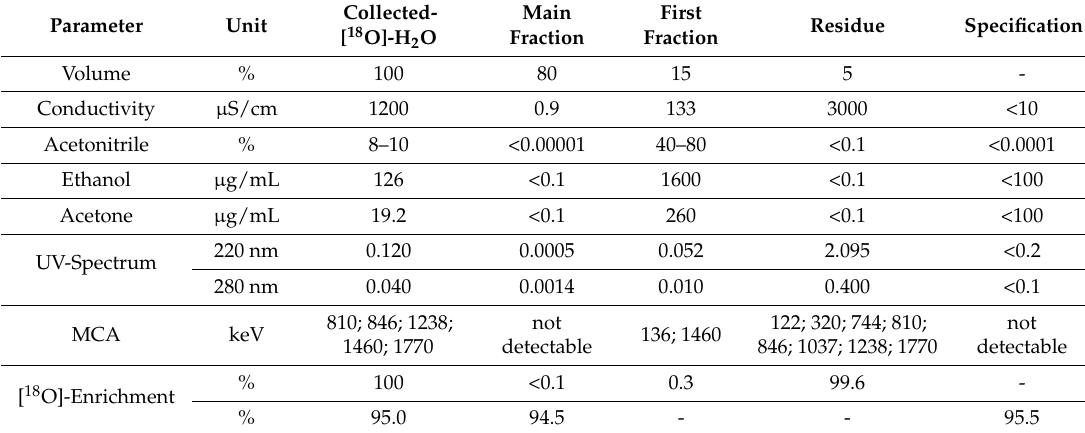
Table 3. Quality of the recovered [ 18 O]-water.